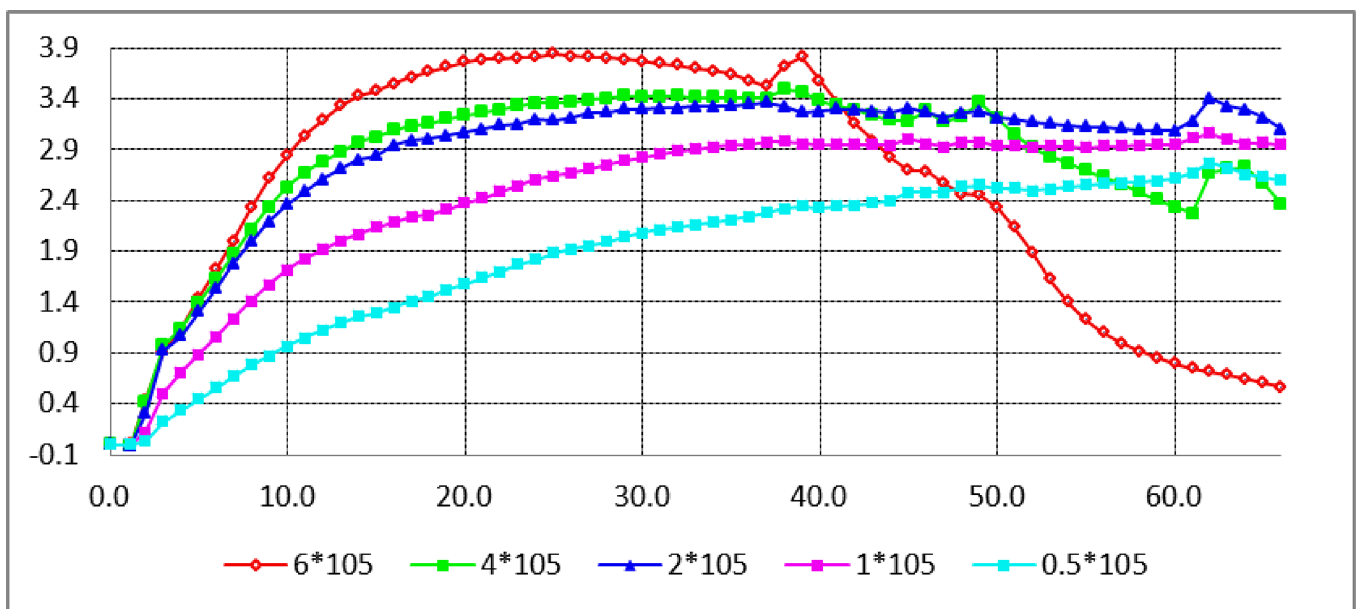
Fig 2. PC-3 cell proliferation curves at different seeding densities. In order to determine the optimal innoculation density of PC-3 cells, we adoptedfive cell seedingdensitiessuch as 6 * 10 5 , 4 * 10 5 , 2 * 10 5 , 1 * 10 5 , and 0.5 * 10 5 cell/ml.